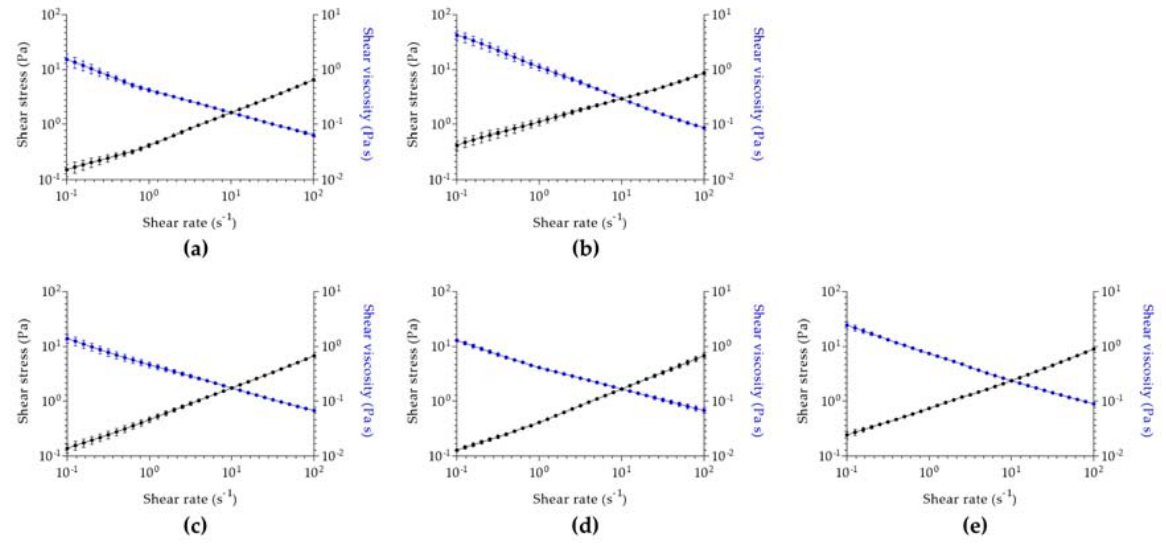
Figure 3. Viscosimetry analysis of ( a ) alginate/fucoidan, ( b ) menthol-alginate/fucoidan, ( c ) linalool- alginate/fucoidan, ( d ) bergamot-alginate/fucoidan, and ( e ) pinene-alginate/fucoidan. Data expressed as mean ± SD of n = 3 different hydrogel batches.